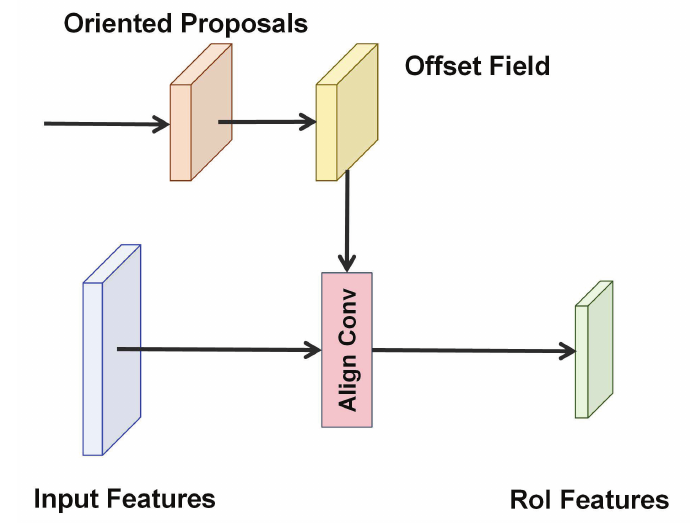
Figure 6. The details of RoI feature extractor